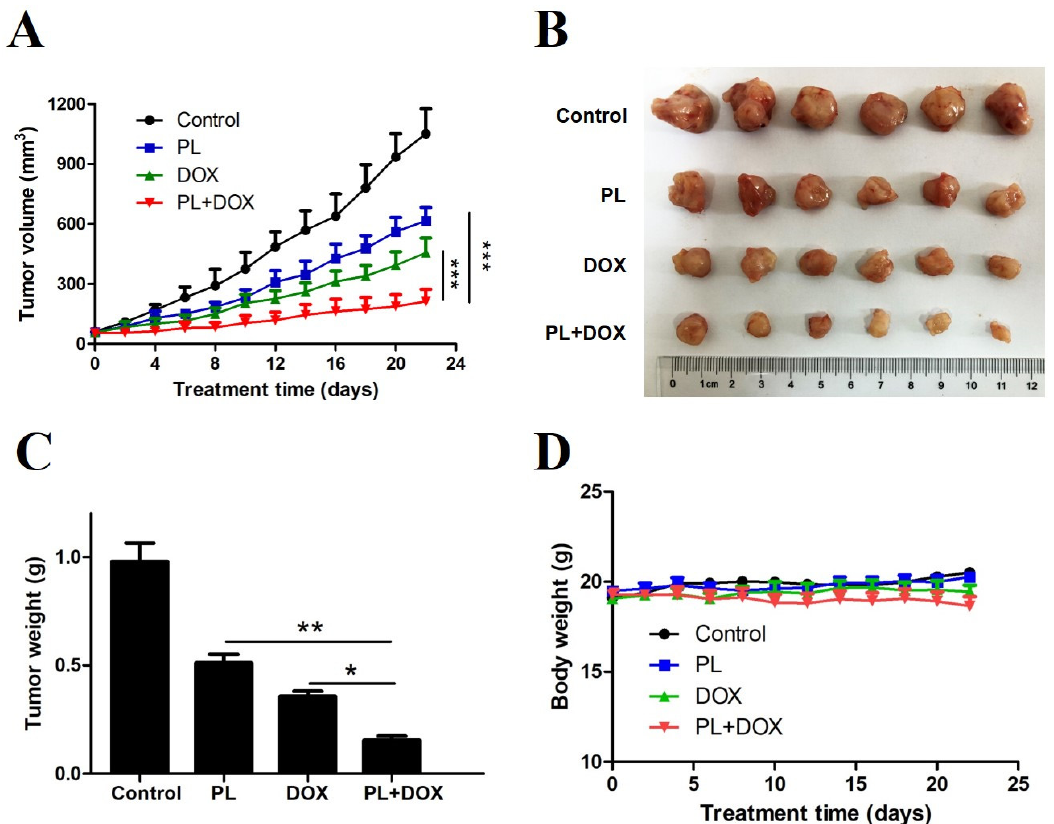
Figure 6. Piperlongumine and doxorubicin synergistically suppress xenograft tumor growth of TNBC cells. ( A ) Female nude mice were injected with 5 × 10 6 MDA-MB-231 cells in the right mammary gland and were randomly divided into 4 groups (n = 6 per group) when the tumor volume reached 50 mm 3 . Nude mice were then treated with DMSO, PL, DOX, or with a combination via i.p. injections every other day. ( B ) All nude mice were sacrificed on day 22 after treatment, and tumors were collected and recorded. ( C ) Each tumor collected from nude mice was weighed and analyzed. ( D ) Treatment with PL and DOX or a combination did not show a significant effect on mouse body weight. * p < 0.05, ** p < 0.01, *** p < 0.001 compared to the compared group.